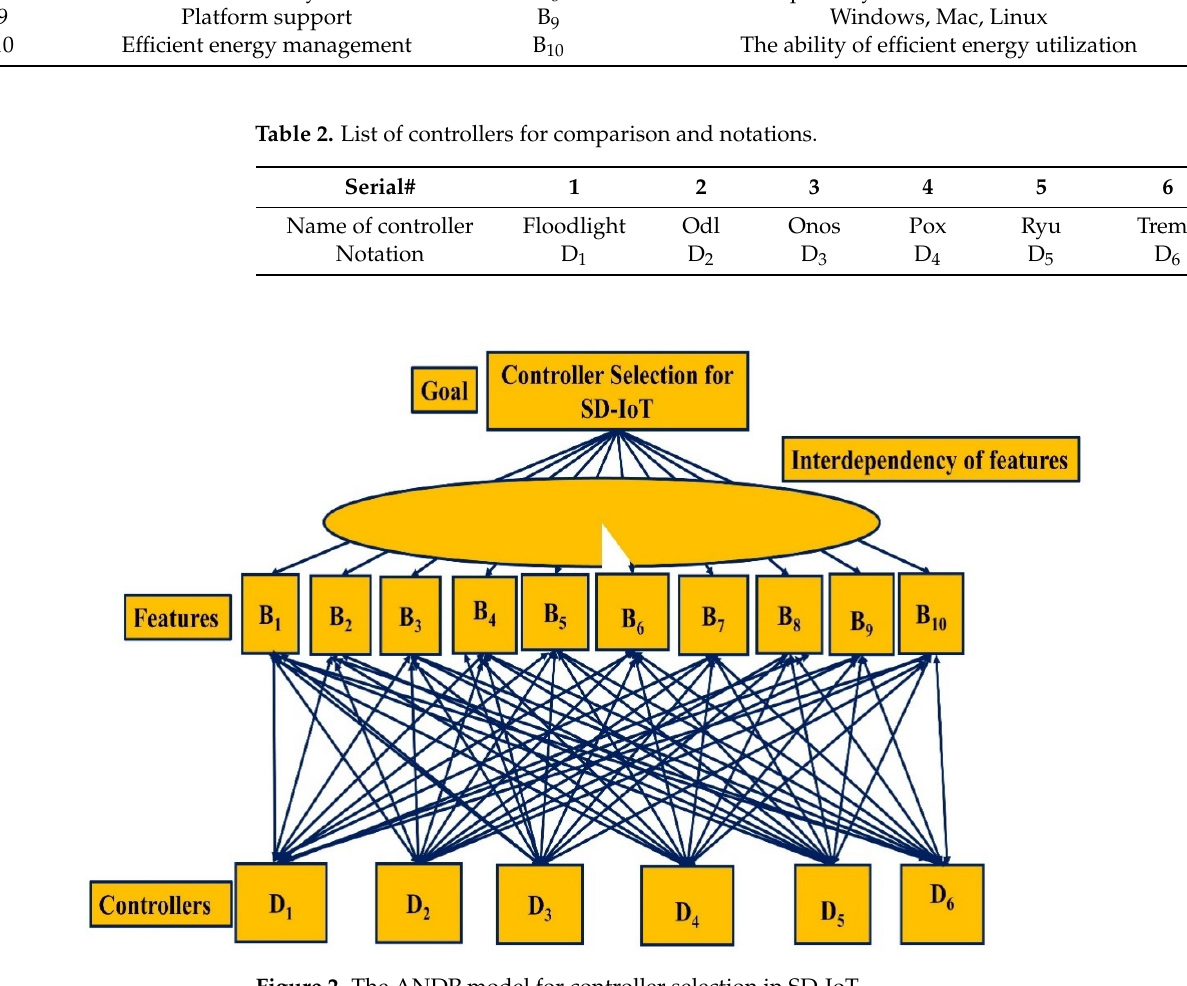
Figure 2. The ANDP model for controller selection in SD-IoT. Table 1. List of features for SD-IoT performance evaluation.